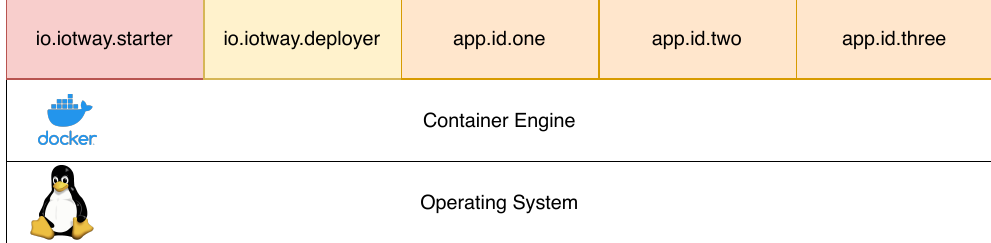
Figure 4. The IoTWay product software